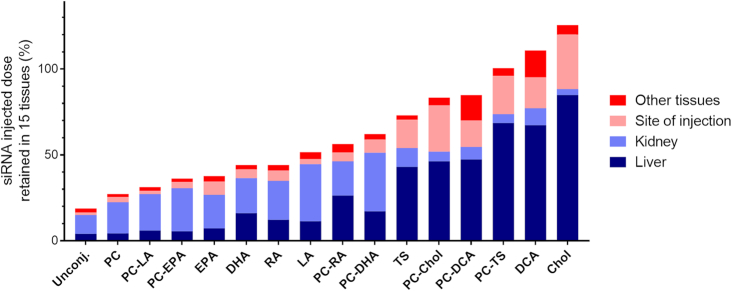
The nature of the lipid conjugate has a profound impact on siRNA tissue retention. Bar graph showing percent of the injected dose cumulatively retained in mice across all 15 tissues 48 h after a single subcutaneous injection of 20 mg/kg conjugated siRNA (average of n = 3 mice). Stacked bars indicate the percent of the retained dose in liver, kidney, site of injection and others tissues. More than 80% of unconjugated siRNAs are cleared while highly hydrophobic compounds are retained quantitatively.